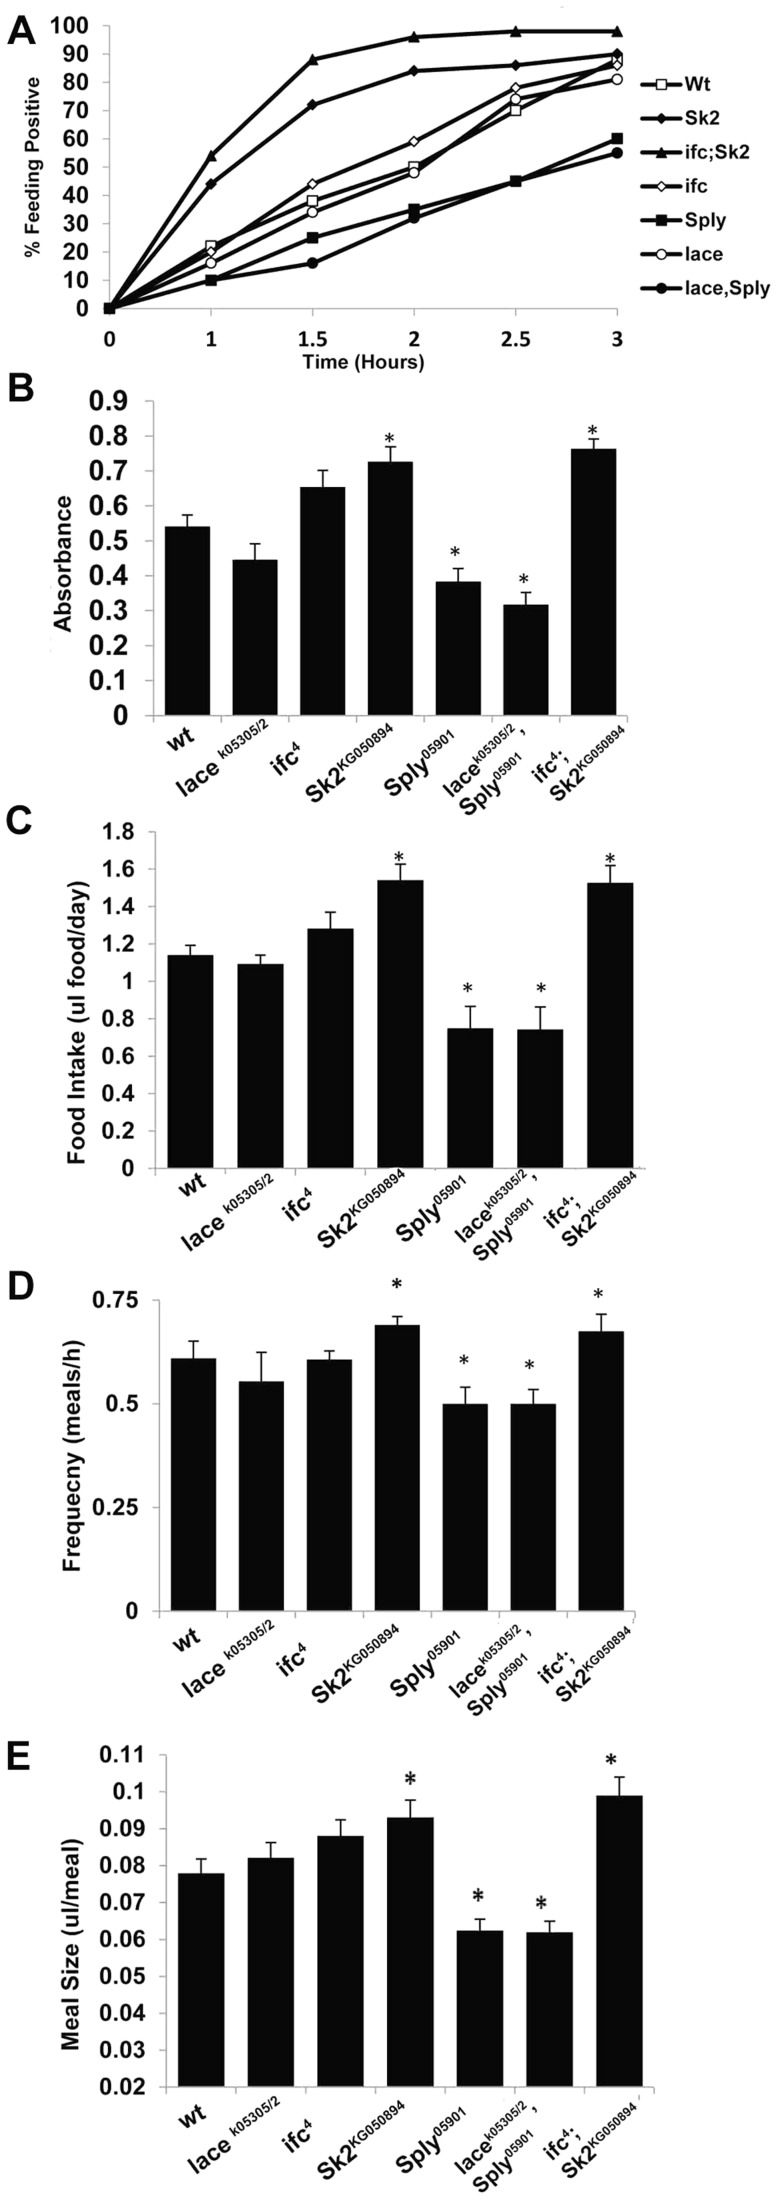
SL Metabolism and feeding behavior.Two different experimental approaches were used to determine appetite response, relative meal volume and mean daily food intake. (A) Flies starved for 3 hours where transferred to synthetic food dyed with 0.01% Bromophenol blue. Three sets of (n = 100) flies were scored for blue positive abdomens over time. The starvation-induced appetite response was plotted as % of fly population that fed overtime. (B) Flies from A that scored positive at 2.5 hours were collected, homogenized and evaluated for Bromophenol blue content by measuring absorbance at 545 nm. Absorbance is proportional to relative meal volume and shown as the mean of three sets of (n = 25) flies. The capillary feeding (CAFE) assay was performed to determine (C) mean daily intake of liquid food media per day and (D) the number of meals consumed per hour, which were used to calculate (E) the average meal volume. Error bars are represented by the S.E.M. *p-values<0.05, **<0.01.